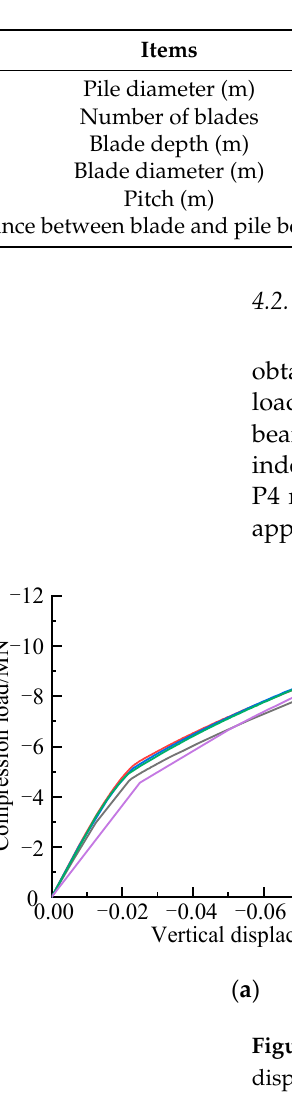
Table 3. Helical pile parameter for various pitch values.